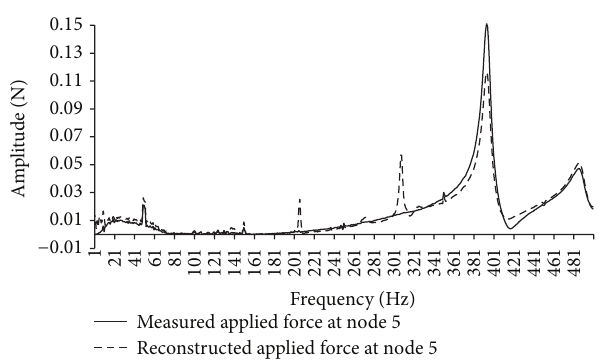
Figure 16: Experimental and reconstructed applied load 𝐹 5 .